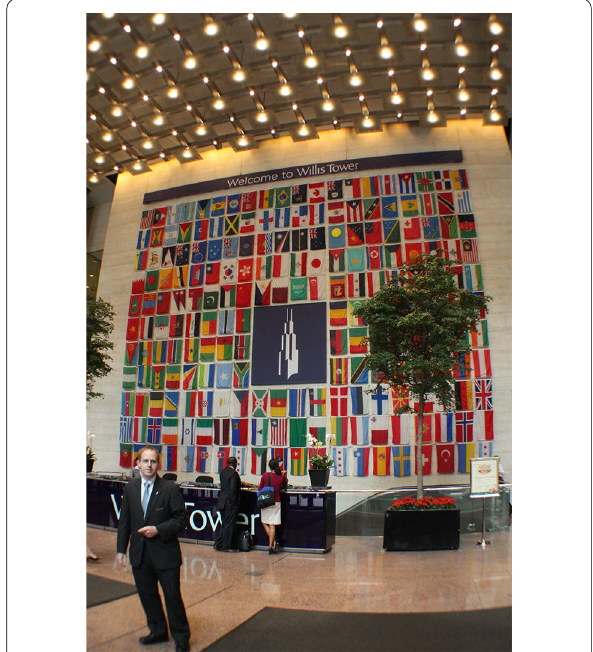
Fig. 21 The Sears Tower in Chicago, a symbol of global